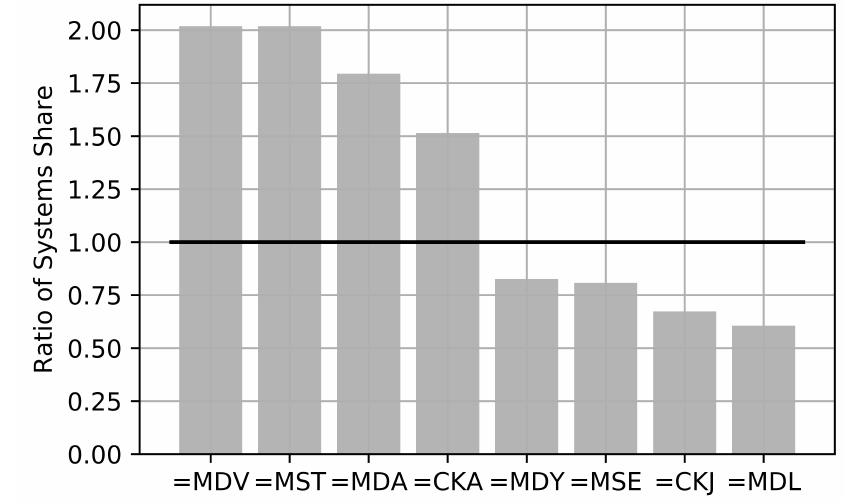
Figure 4. The ratio of Share of Systems with expected long term and reliable detection to all possible